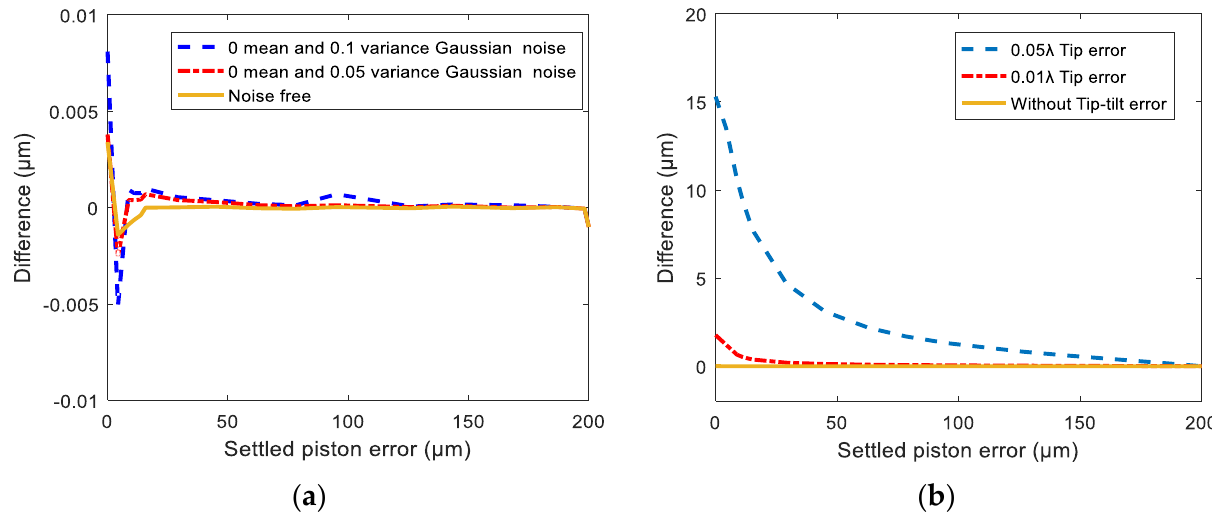
Figure 9. The piston error detection accuracy under ( a ) different CCD image noise values and ( b ) different tip-tilt aberra-